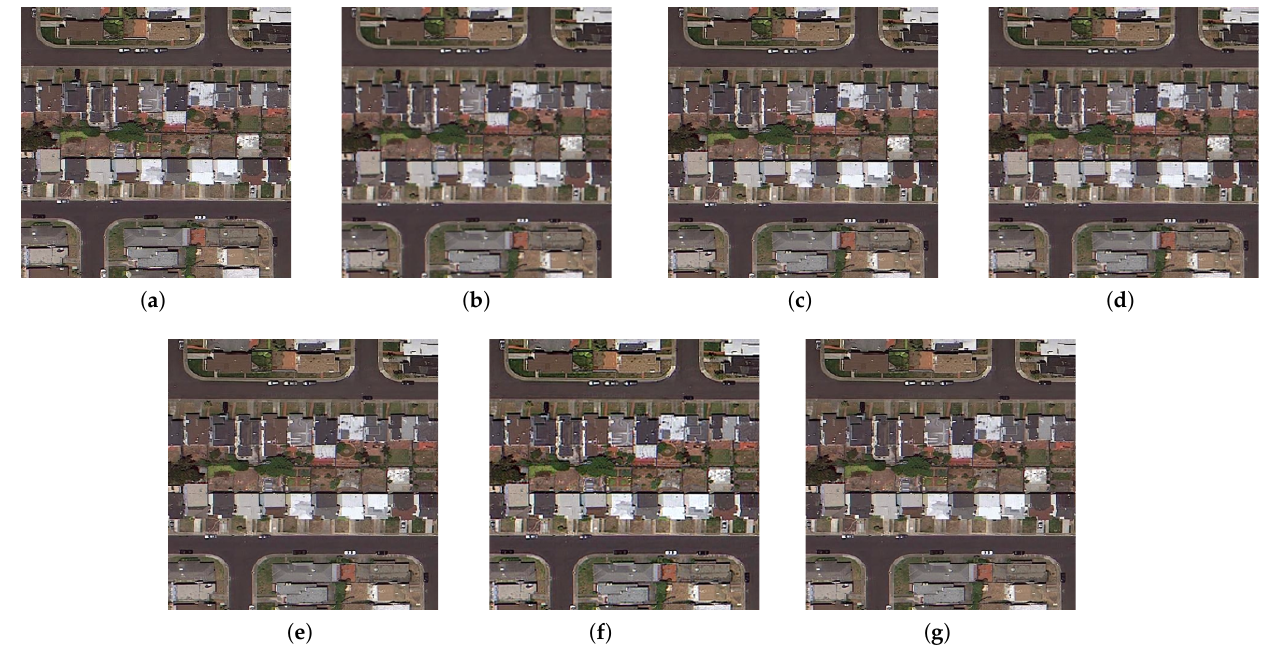
Figure 13. Comparison of visual results of different SR methods with × 2 super-resolution on the RSC11 [44] dataset (residential area scene). ( a ) HR. ( b ) Bicubic. ( c ) EDSR [68]. ( d ) RCAN [81].